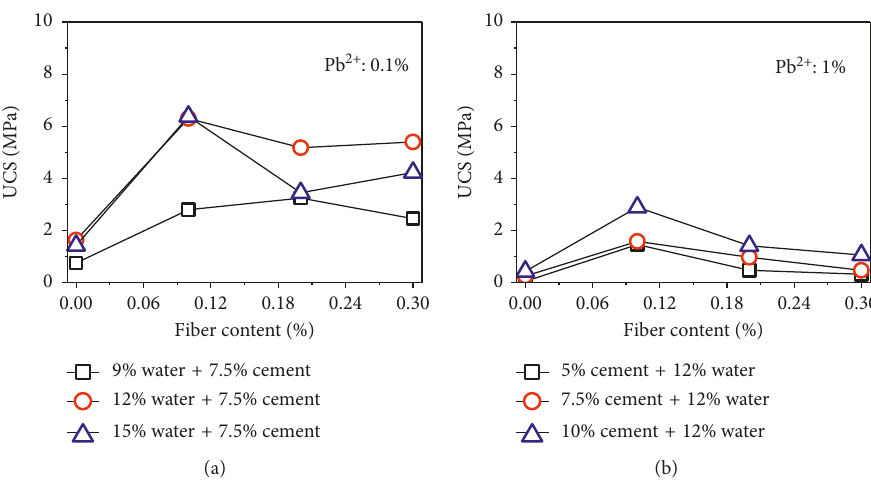
Figure 4: UCS of fiber-reinforced samples under 9 cycles. (a) Various percentages of water content based on 7.5% cement+0.1% Pb(II). (b) Various percentages of cement content based on 12% water+ 1% Pb(II).